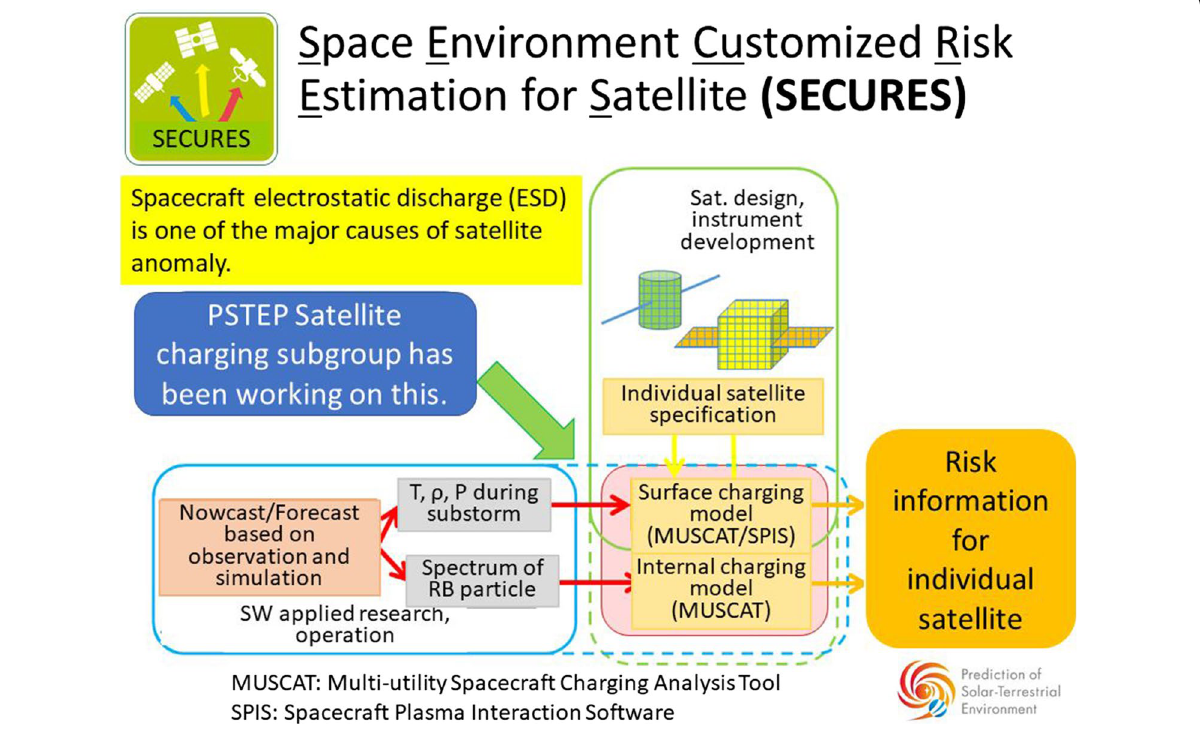
Fig. 1 Conceptual picture of